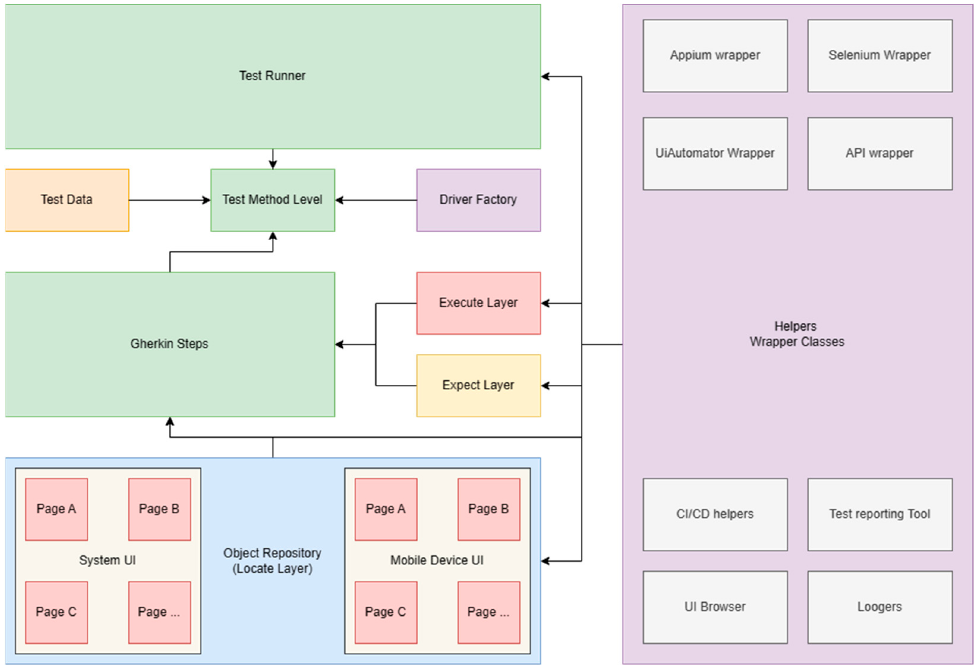
Figure 16. Example of a custom automation framework diagram.